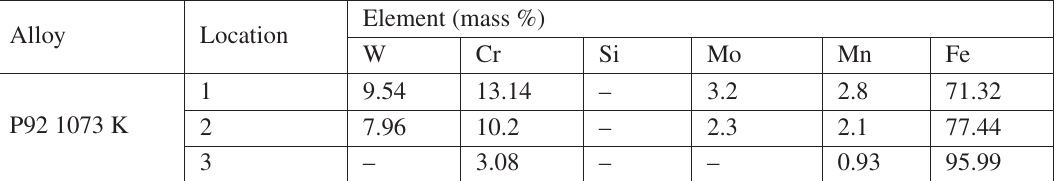
Table 6. EDAX analysis of various points on P92 alloys at 1073 K.